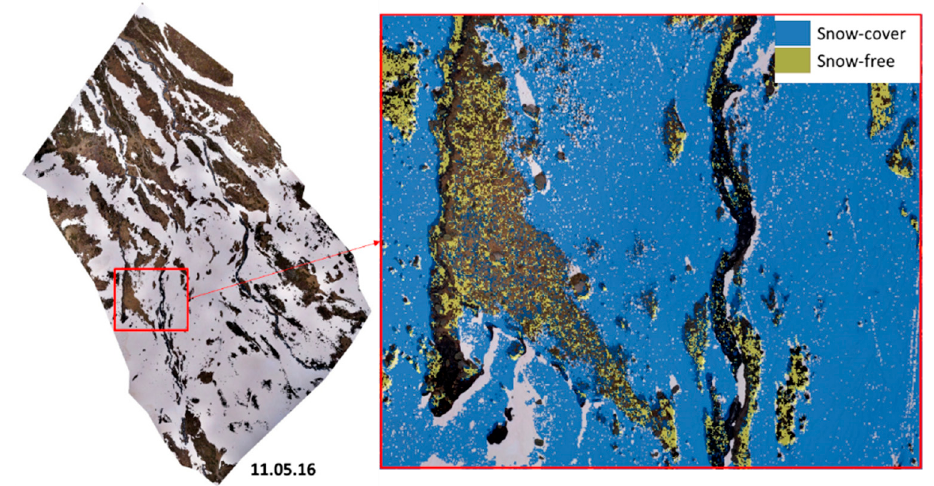
Figure 8. TLS-based snow cover map of 11.05.2016 overlapped with UAS-based orthophoto.